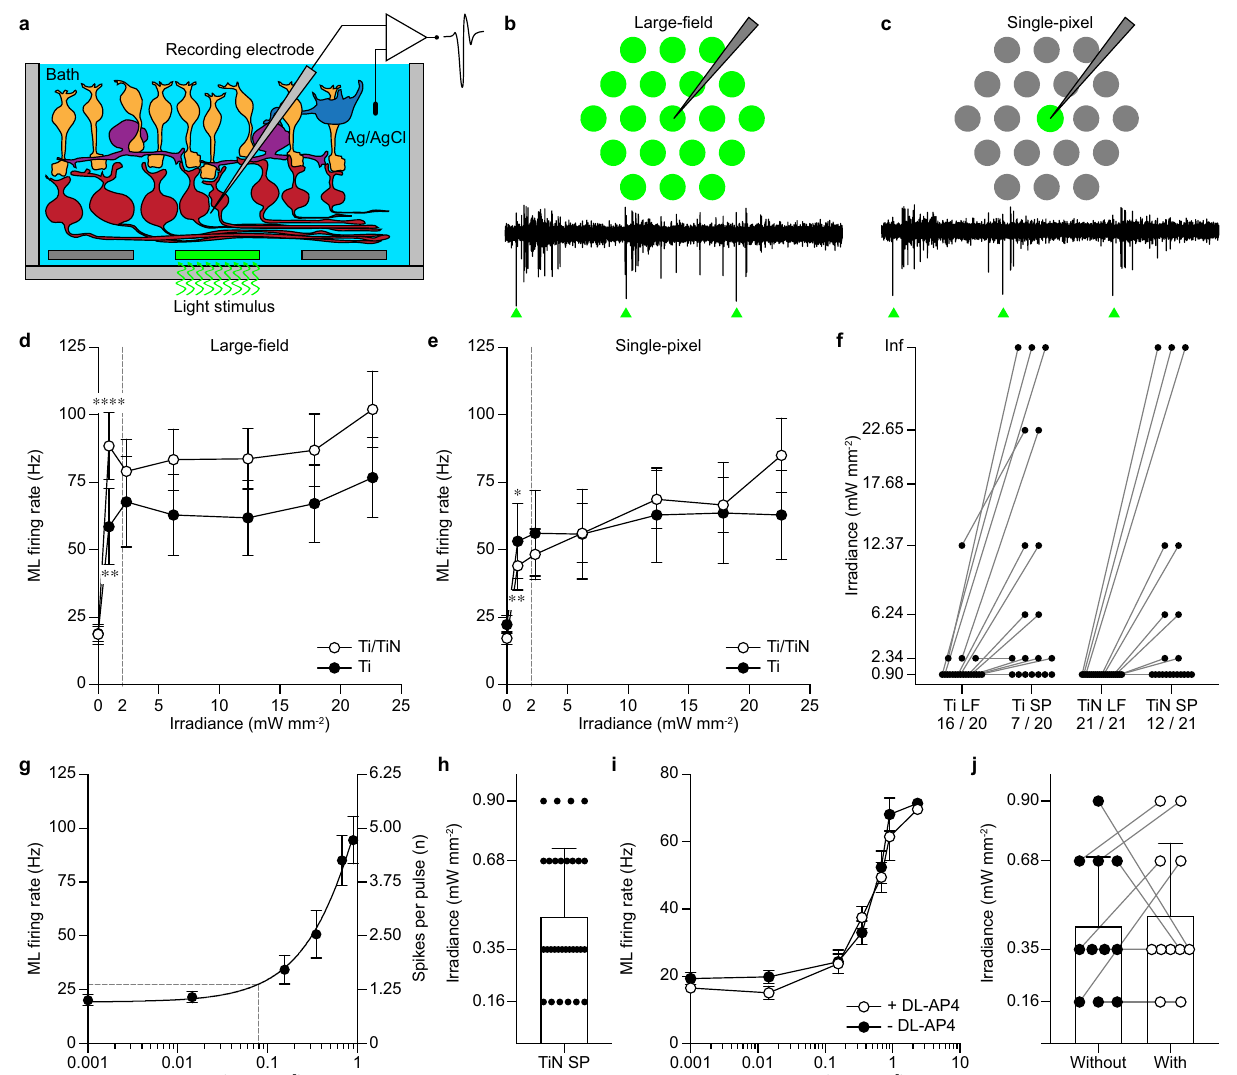
Fig. 4 Single-pixel stimulation of retinal ganglion cells. a Sketch of the recording setup. b , c Representative responses from a retinal ganglion cell upon three consecutive light pulses (560 nm, 10 ms, 0.9 mW mm − 2 ) with large- fi eld illumination ( b ) and single-pixel illumination ( c ). The green triangles correspond to the onset of each pulse. d , e Comparison of the stimulation ef fi cacy during large- fi eld ( d ) and single-pixel ( e ) illumination under increasing irradiances with Ti-based ( n = 20 RGCs, mean ± s.e.m.) and TiN-based pixels ( n = 21 RGCs, mean ± s.e.m.). f Change in the activation threshold from large- fi eld to single-pixel illumination for both Ti pixels ( n = 20 RGCs) and TiN-coated pixels ( n = 21 RGCs). The numbers for each column are the fraction of RGCs activated by a 10-ms light pulse of 0.9 mW mm − 2 . Inf means that the RGC does not show ML activity at any of the irradiance levels tested. LF large- fi eld, SP single-pixel. g ML fi ring rate ( n = 30 RGCs, mean ± s.e.m.) at low irradiance levels for TiN-coated pixels and single-pixel illumination. The black line is the second-order polynomial interpolation ( R 2 = 0.29). The grey dashed lines show the activation threshold computed as the irradiance eliciting 10% of the maximal ML fi ring rate at 0.9 mWmm − 2 . The right axis shows the quanti fi cation of the average numbers of spikes elicited per light pulse. h Activation threshold for each RGCs with single-pixel illumination and TiN-coated pixels (mean ± s.d.). i ML fi ring rate ( n = 11 RGCs, mean ± s.e.m.) at low irradiance levels for TiN-coated pixels and single-pixel illumination before and after the application of DL-AP4. j Activation threshold for each individual RGC with single-pixel illumination and TiN-coated pixels before (black circles) and after (white circles) the application of DL-AP4 (mean ±